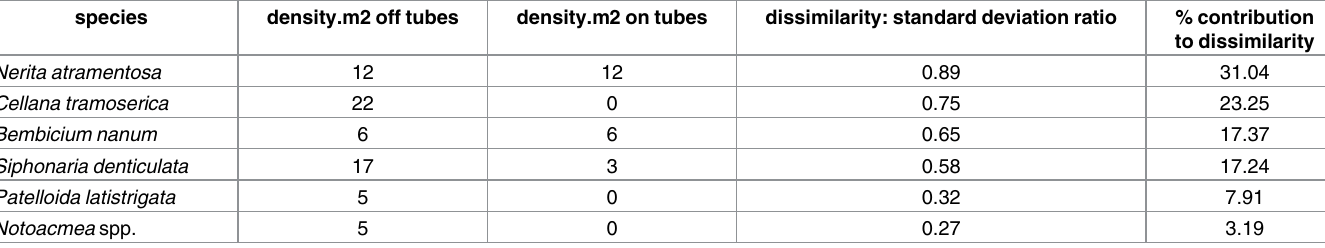
Table 3. SIMPER analysis